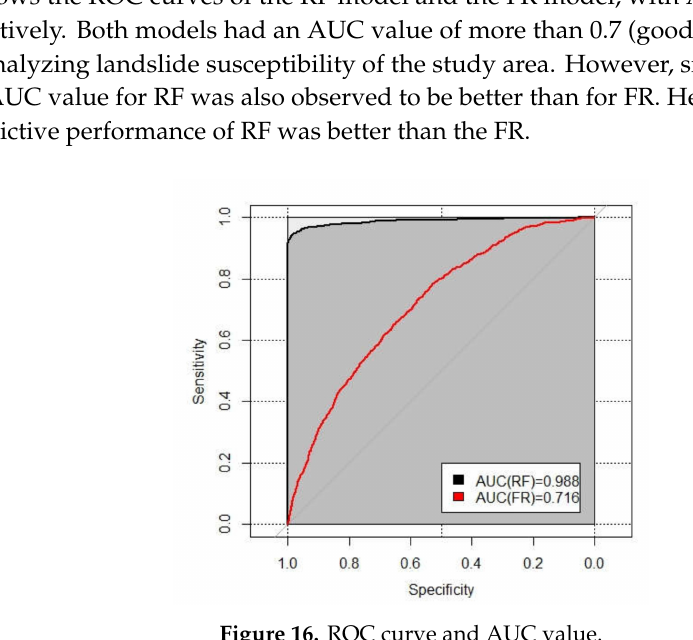
Figure 16. ROC curve and AUC